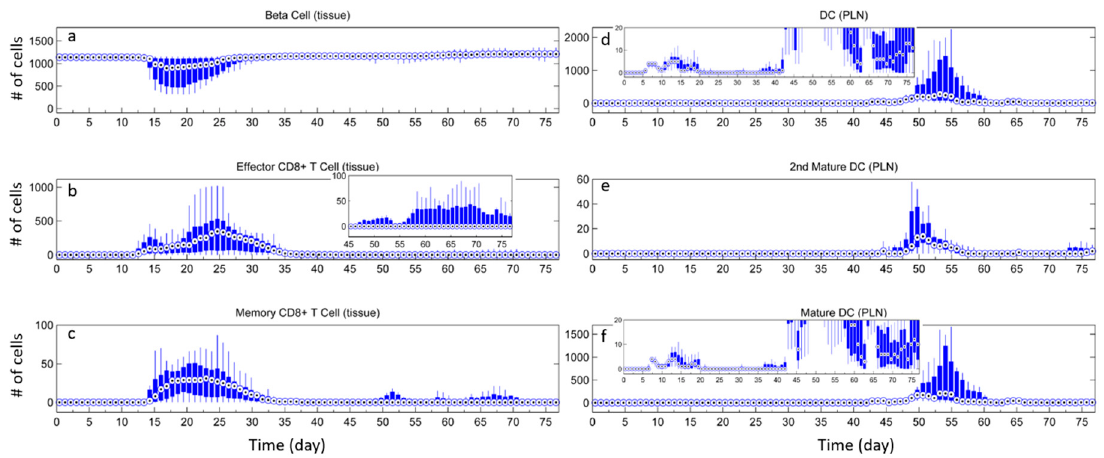
Figure A5. Simulation results for case without inhibiting DCs (case V). Tregs cannot inhibit DCs but can directly inhibit T cells. The number of ( a ) β cells, ( b ) effector CD8 + T cells, ( c ) memory CD8 + T cells- in pancreatic tissue are shown on the left column. The number of ( d ) total DCs, ( e ) 2nd mature DCs, ( f ) mature DCs in PLN are shown on the right column. Inserts (number of cells vs. time) show small change of cell number in the bottom figures. t = 0 days correspond to 3-week age of mouse.